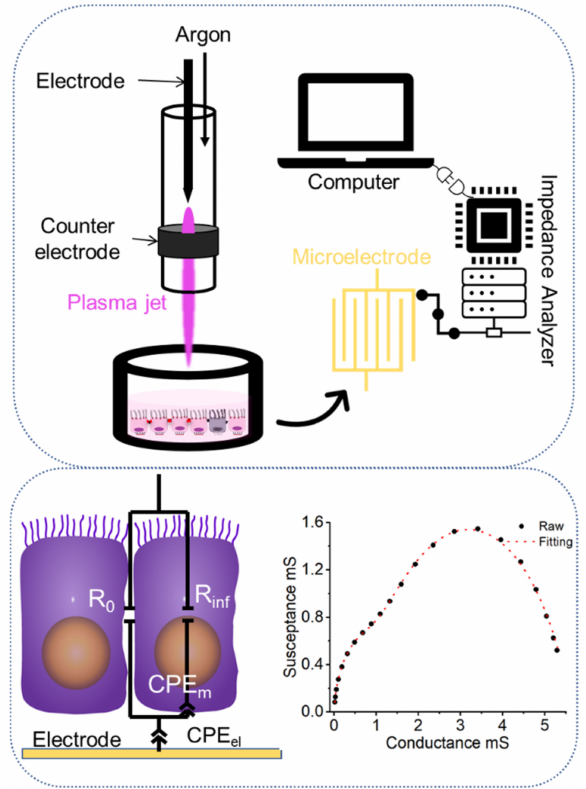
Figure 7. Schematic diagram for CAP treatments and impedimetric